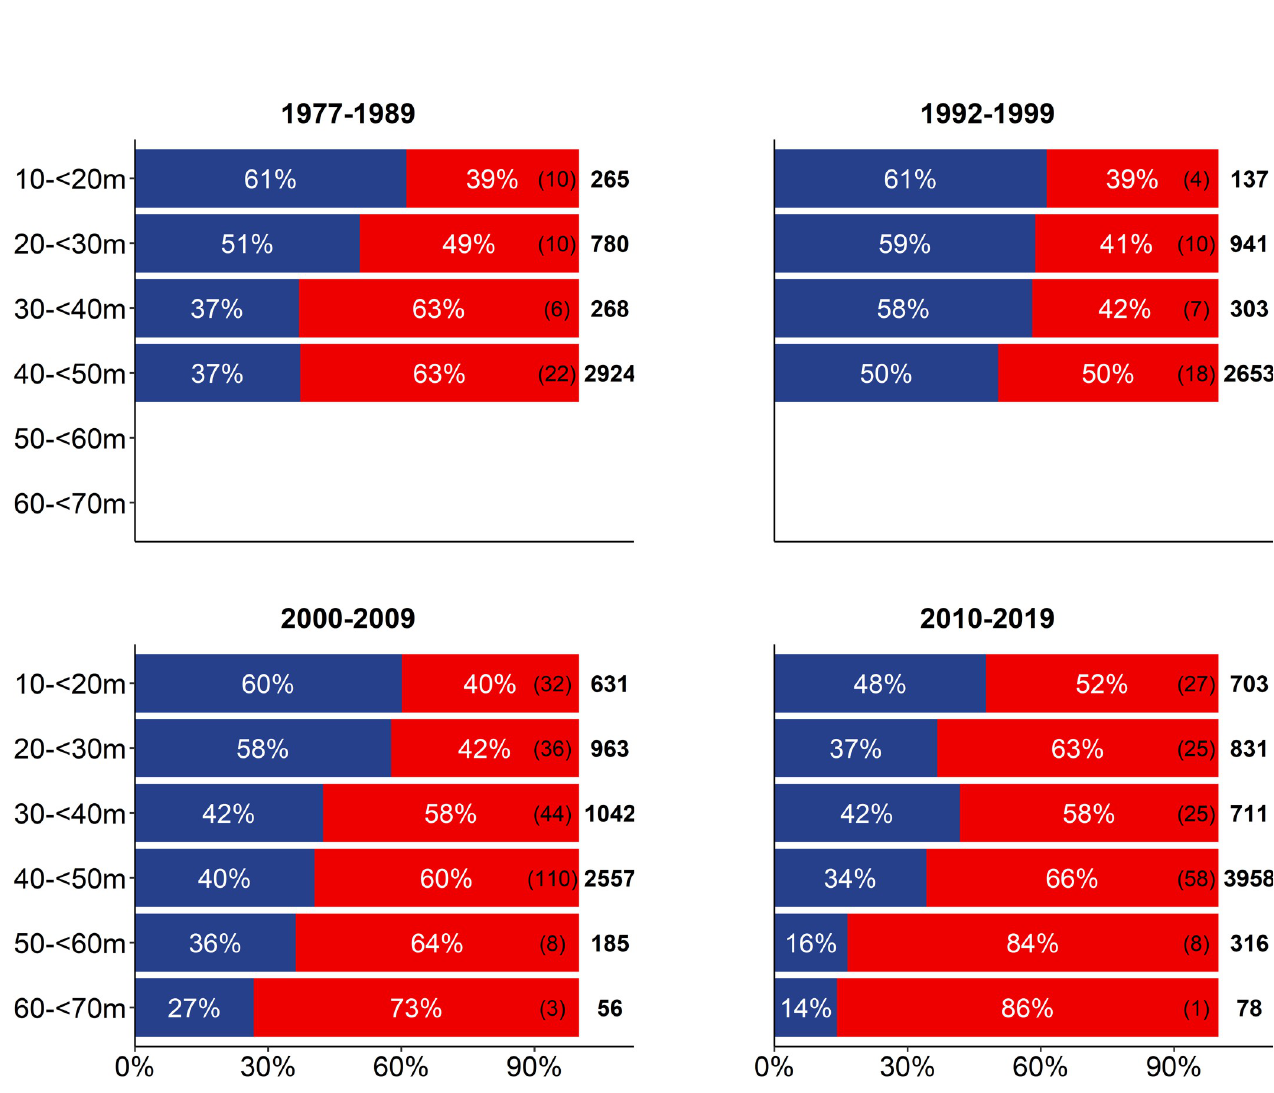
PLOS ONE | https://doi.org/10.1371/journal.pone.0274476 September 28,